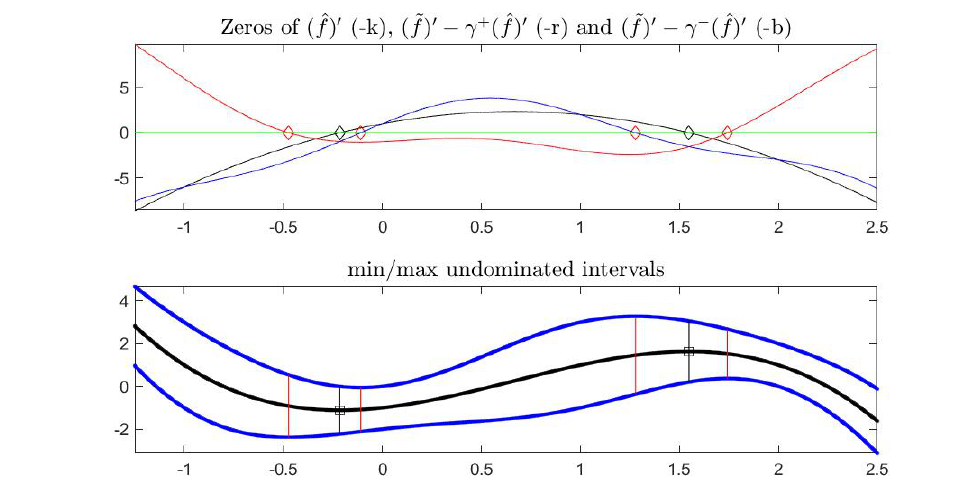
Figure 3. Efficient frontier for min and max points of F ( x ) in Example 1. The top picture reproduces the derivatives of the three relevant functions (cid:98) f ( x ) , (cid:101) f ( x ) − γ + (cid:98) f ( x ) and (cid:101) f ( x ) − γ − (cid:98) f ( x )